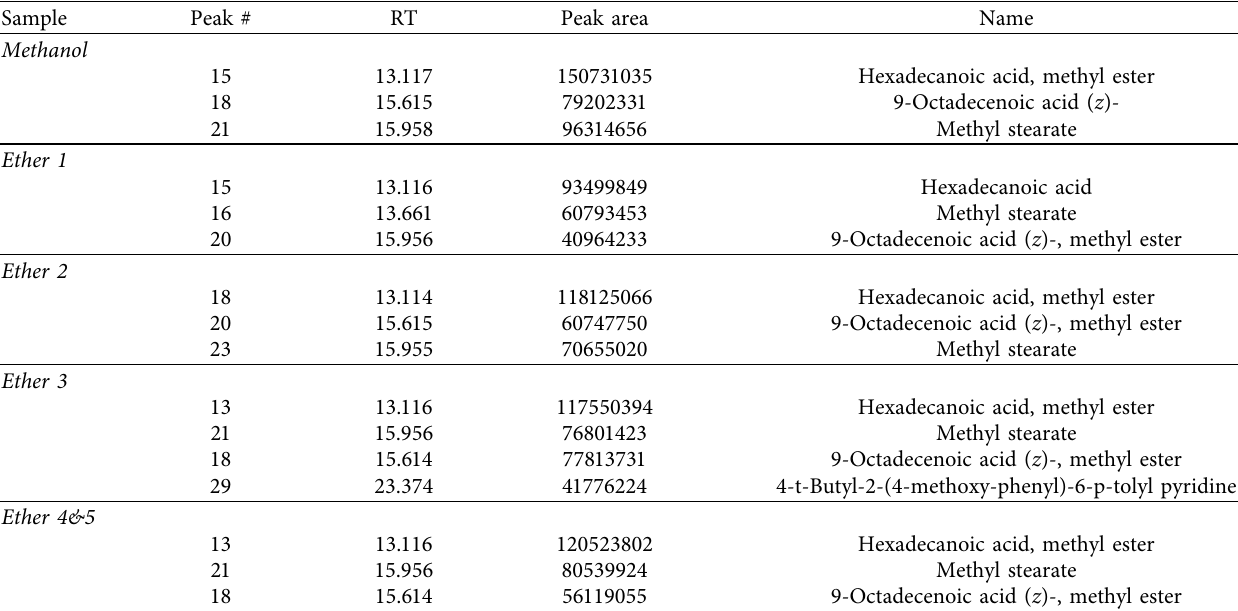
Table 3: Summary of spectra for methanolic and diethyl ether bands’ major peaks.